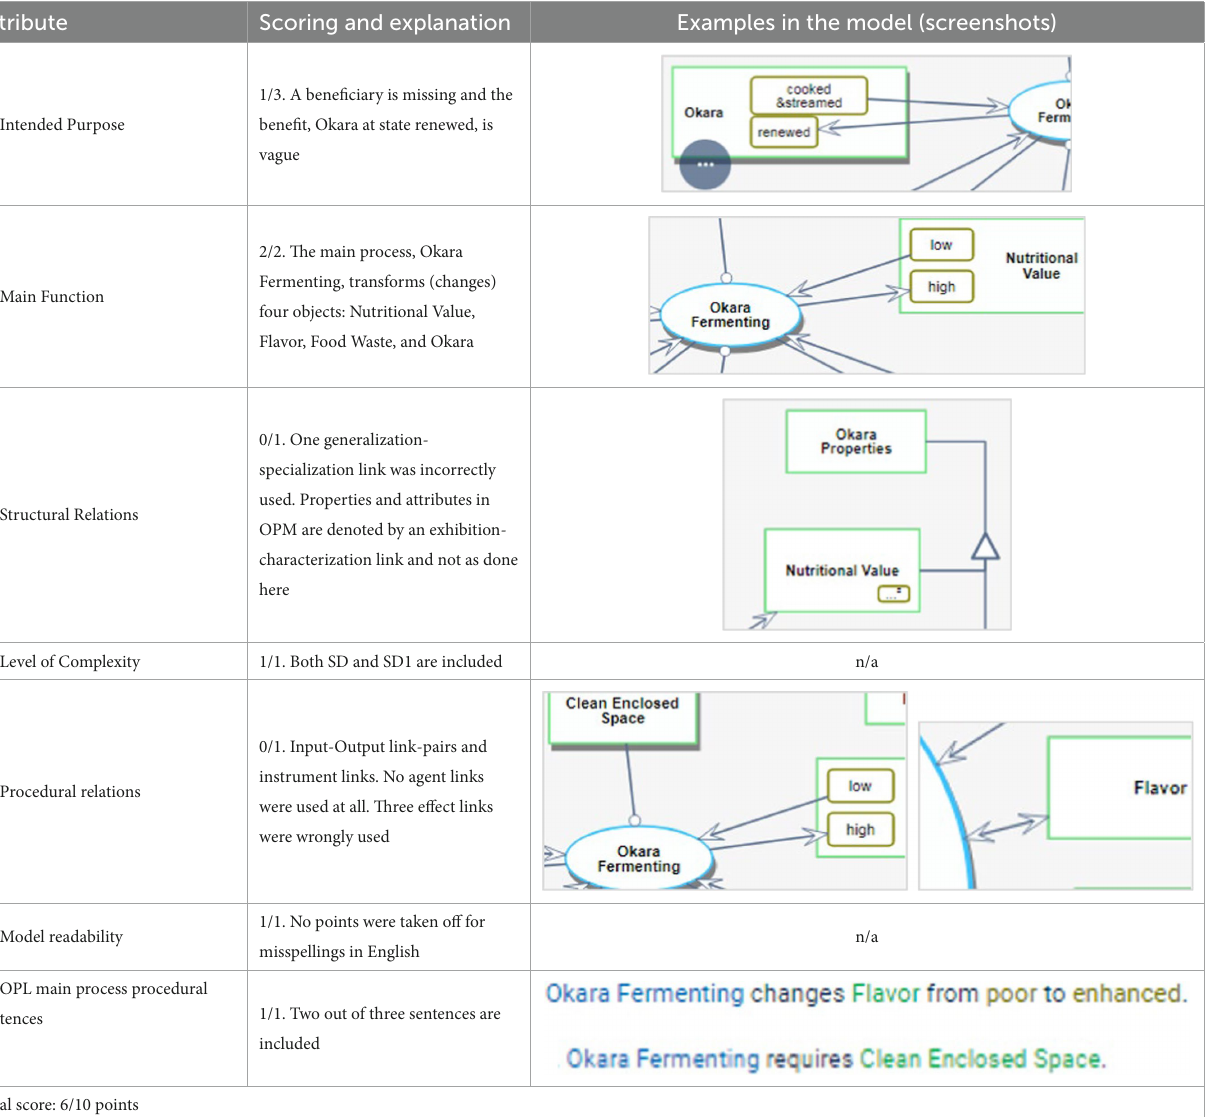
TABLE 6 Scores and explanations for the OPM model created by Anna. Attribute Scoring and explanation Examples in the model